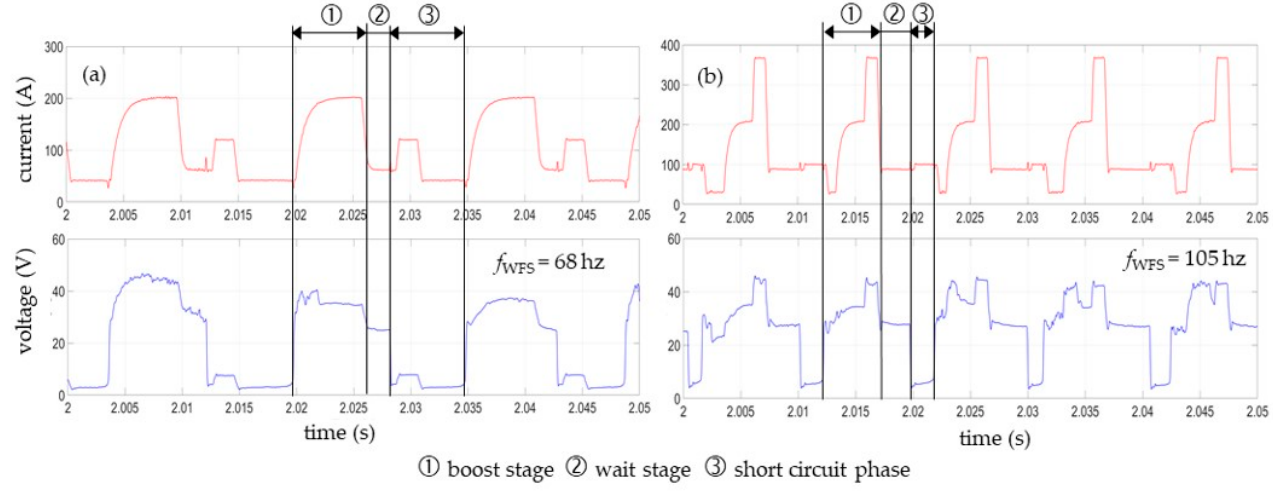
Figure 3. Typical electrical waveform of the CMT cycles for ( a ) CMT 960 and ( b ) CMT